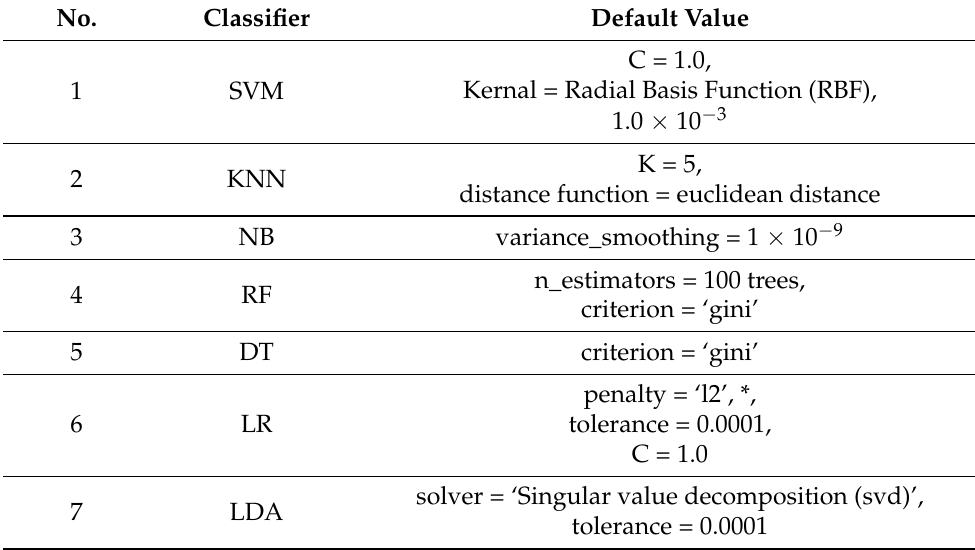
Table 2. Default Parameters for Classification